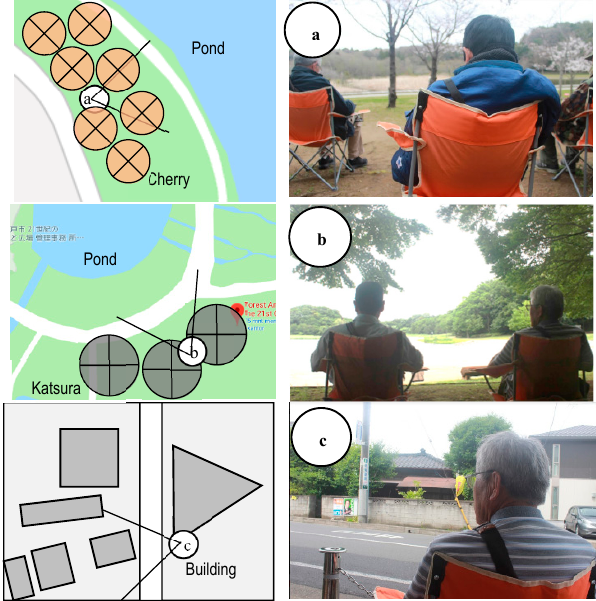
Figure 1. Schematic and photographs displaying the seated-viewing scenes: ( a ) urban park site in spring, ( b ) urban park site in early summer, and ( c ) city area site.